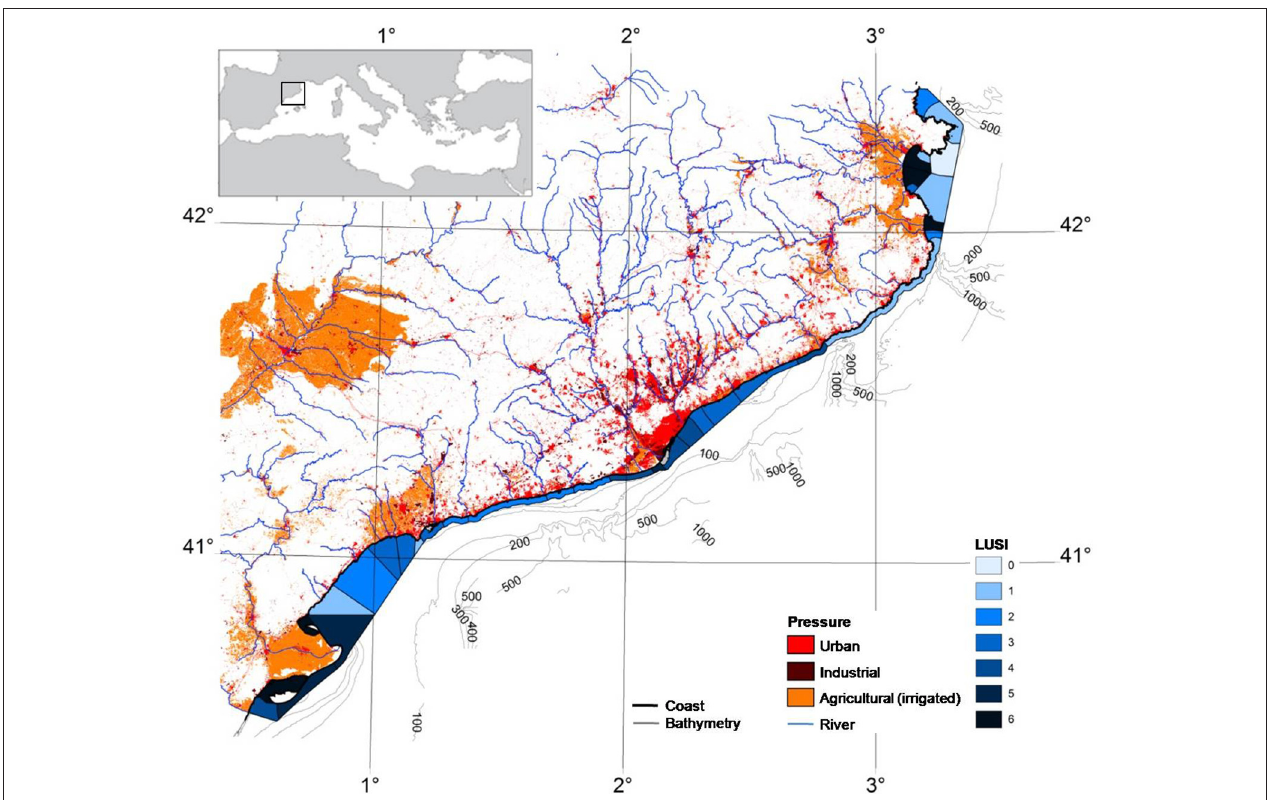
FIGURE 1 | Map of the Catalan coast showing the continental pressures related to LUSI (Land Uses Simplified Index) and the LUSI values of the different coastal water bodies calculated using the 2009 Mapa de Cobertes del Sòl de Catalunya. Urban land use is shown in red, industrial land use in brown and agricultural (irrigated) land use in orange. Rivers are shown in blue and the coastline in black. Water bodies are also shown in blue, with the shade depending on the LUSI value (assigned based on direct integer values). Harbor water bodies were not assessed and are indicated in gray, as is the